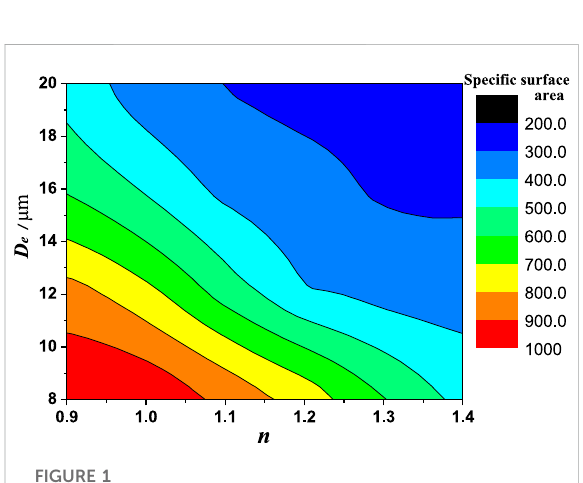
FIGURE 2 The particle size distribution of